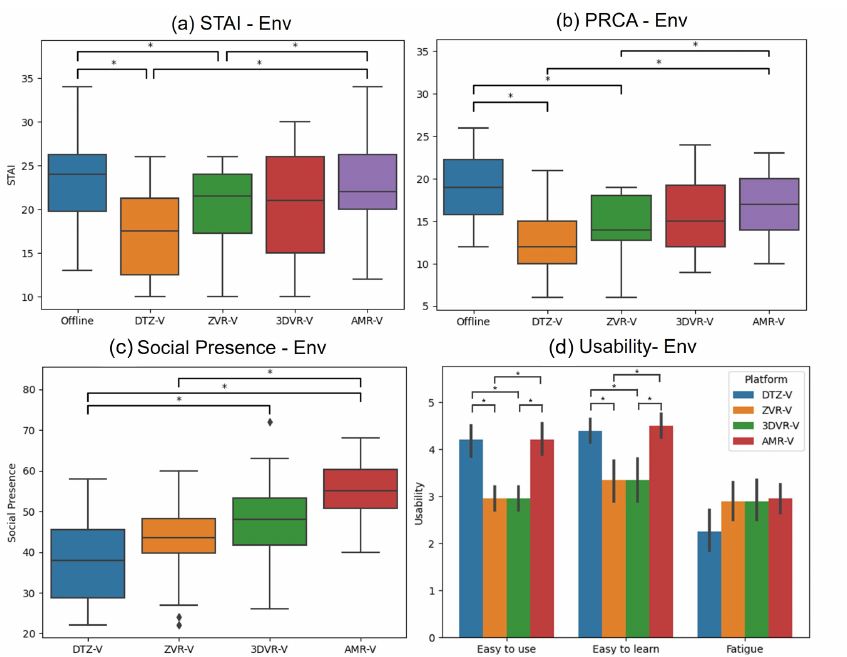
Figure 6. The effects of environment type on the ( a ) levels of anxiety, ( b ) fear of public speaking and ( c ) social presence and ( d ) usability. The * mark indicate statistically significant